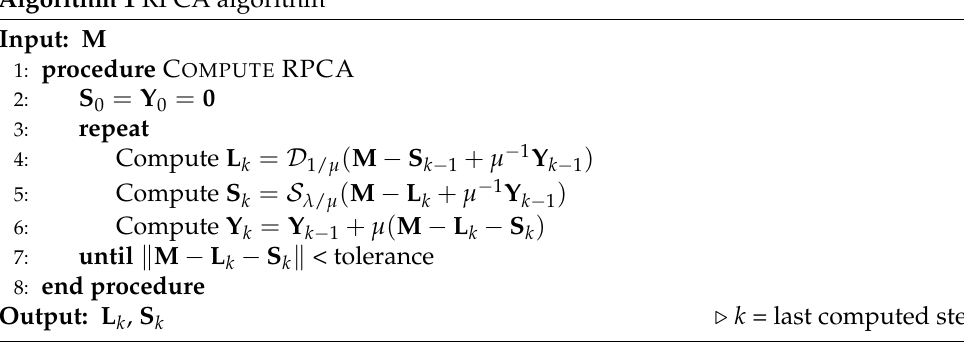
Algorithm 1 RPCA algorithm